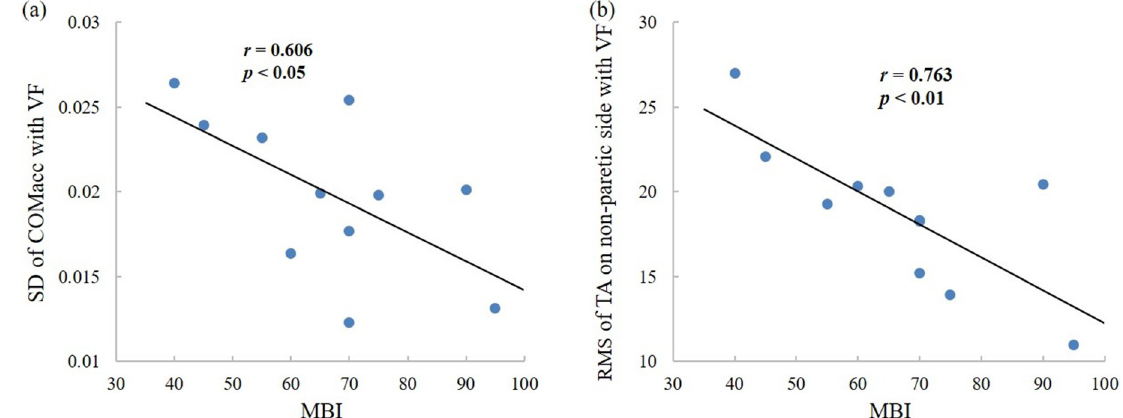
Fig 7. Correlations in the hemiplegic individuals between the Modified Barthel Index (MBI) and (A) the SD of COM acc with visual feedback; (B) the RMS of TA on non-paretic side with visual